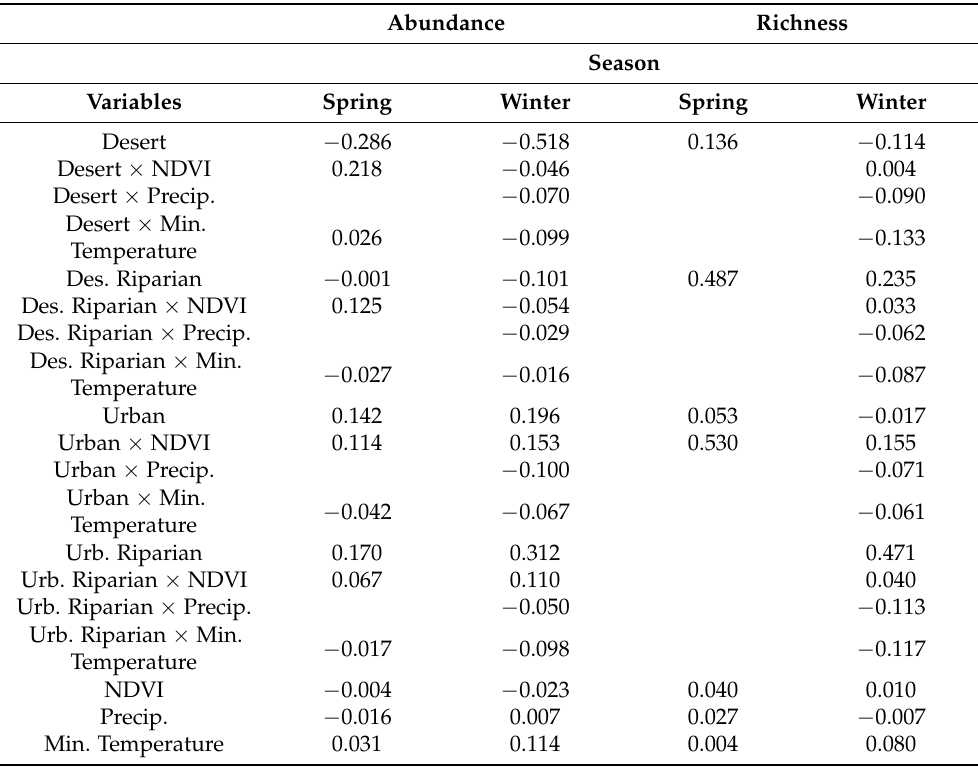
Table 1. Generalized linear mixed models for avian abundance and richness, with combinations of fixed effect terms in the global model. Coefficients were calculated from model averaging based on Akaike information criterion